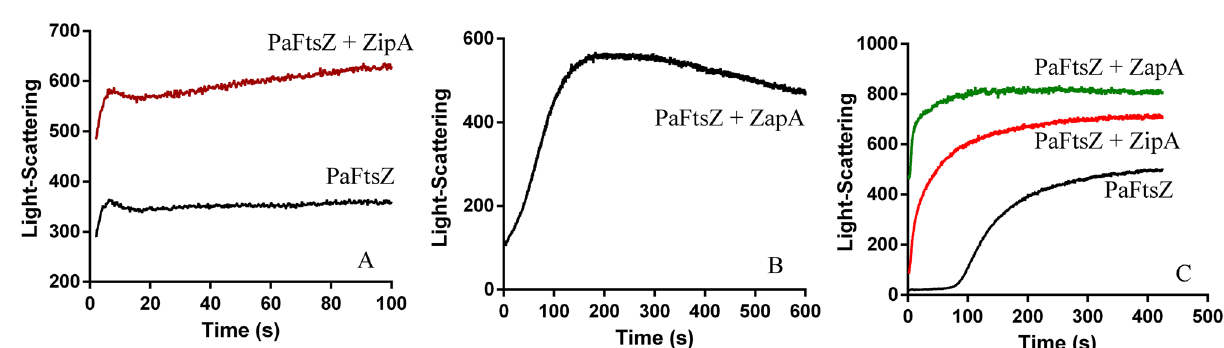
Figure 4. Kinetics of PaFtsZ assembly in the absence of or in the presence of ZipA or ZapA followed by light scattering. (A) shows the pfs formation of 5 µM PaFtsZ with or without 10 µM PaZipA in HMK buffer. (B) shows the bundles formation of 5 µM PaFtsZ with 10 µM PaZapA in HMK buffer measured by low sensitive light scattering. (C) shows the bundles formation of 5 µM PaFtsZ, 5 µM PaFtsZ with 10 µM PaZipA, and 5 µM PaFtsZ with 10 µM PaZapA in MMK